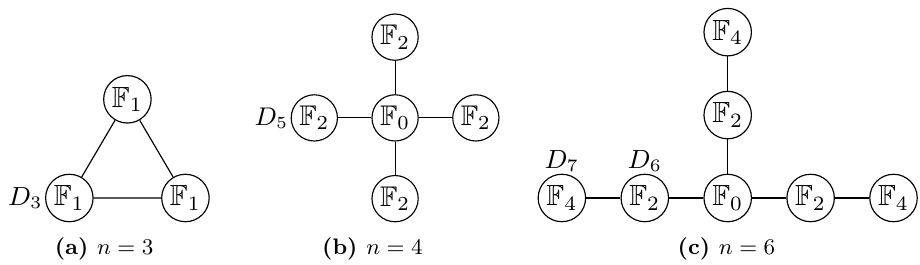
Figure 1. Schematic structure of compact divisors in elliptic (cid:12)brations over O ( (cid:0) n ) ! P 1 as a(cid:14)ne Dynkin diagrams for n = 3 ; 4 ; 6. The divisor D r